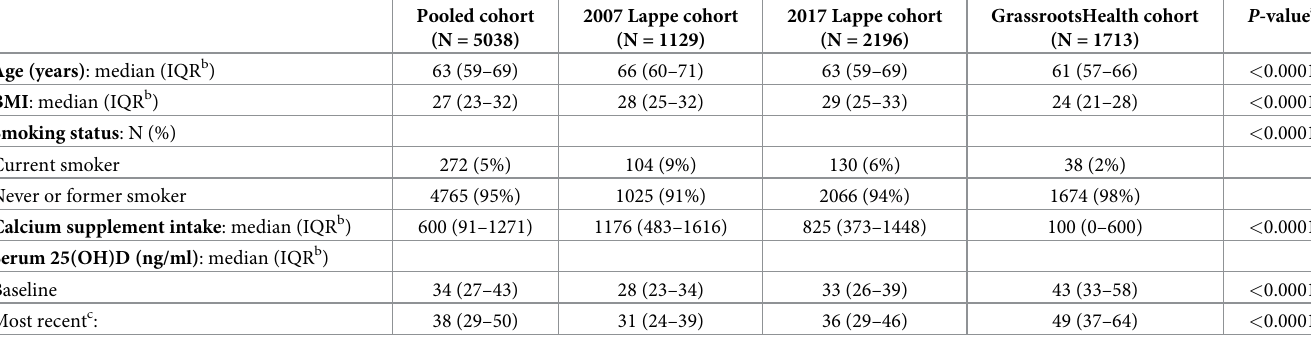
Table 1. Characteristics of the pooled, 2007 Lappe, 2017 Lappe, and GrassrootsHealth